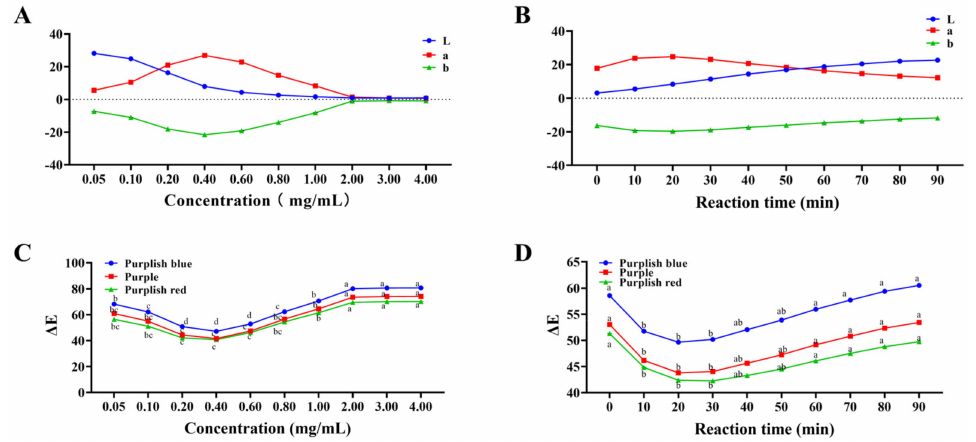
Figure 1. The optimisation of concentrations and reaction time of anthocyanin colour. ( A ) The effect of concentrations of anthocyanins on International Commission on Illumination (CIE) parameters; ( B ) the effect of reaction time of anthocyanins on CIE parameters; ( C ) the effect of concentrations of anthocyanins on colour differences; ( D ) the effect of reaction time of anthocyanins on colour differences. Groups with different letters indicate significant differences, p < 0.05; the same letters indicate non − significant differences, p >